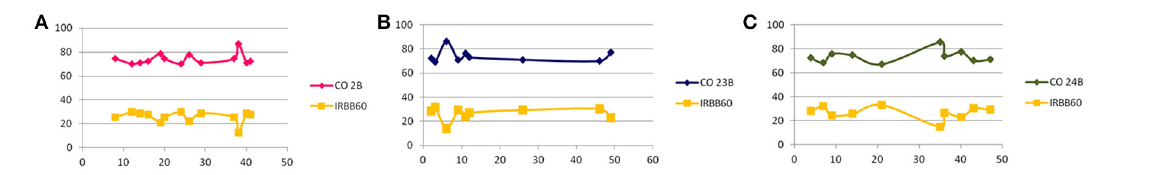
FIGURE 3 | Graphical representation of background analysis. Y- axis represents the percentage of recurrent parent genome recovery using polymorphic SSR markers distributed all over the 12 chromosomes (RPG SSR ) in BC 1 F 1 generation (A) CO 2B × IRBB60, (B) CO 23B × IRBB60, and (C) CO 24B × IRBB60. While, X- axis indicates the number of agro-morphologically selected plants from foreground analysis subjected to RPG SSR analysis carrying xa5 , xa13, and Xa21 gene